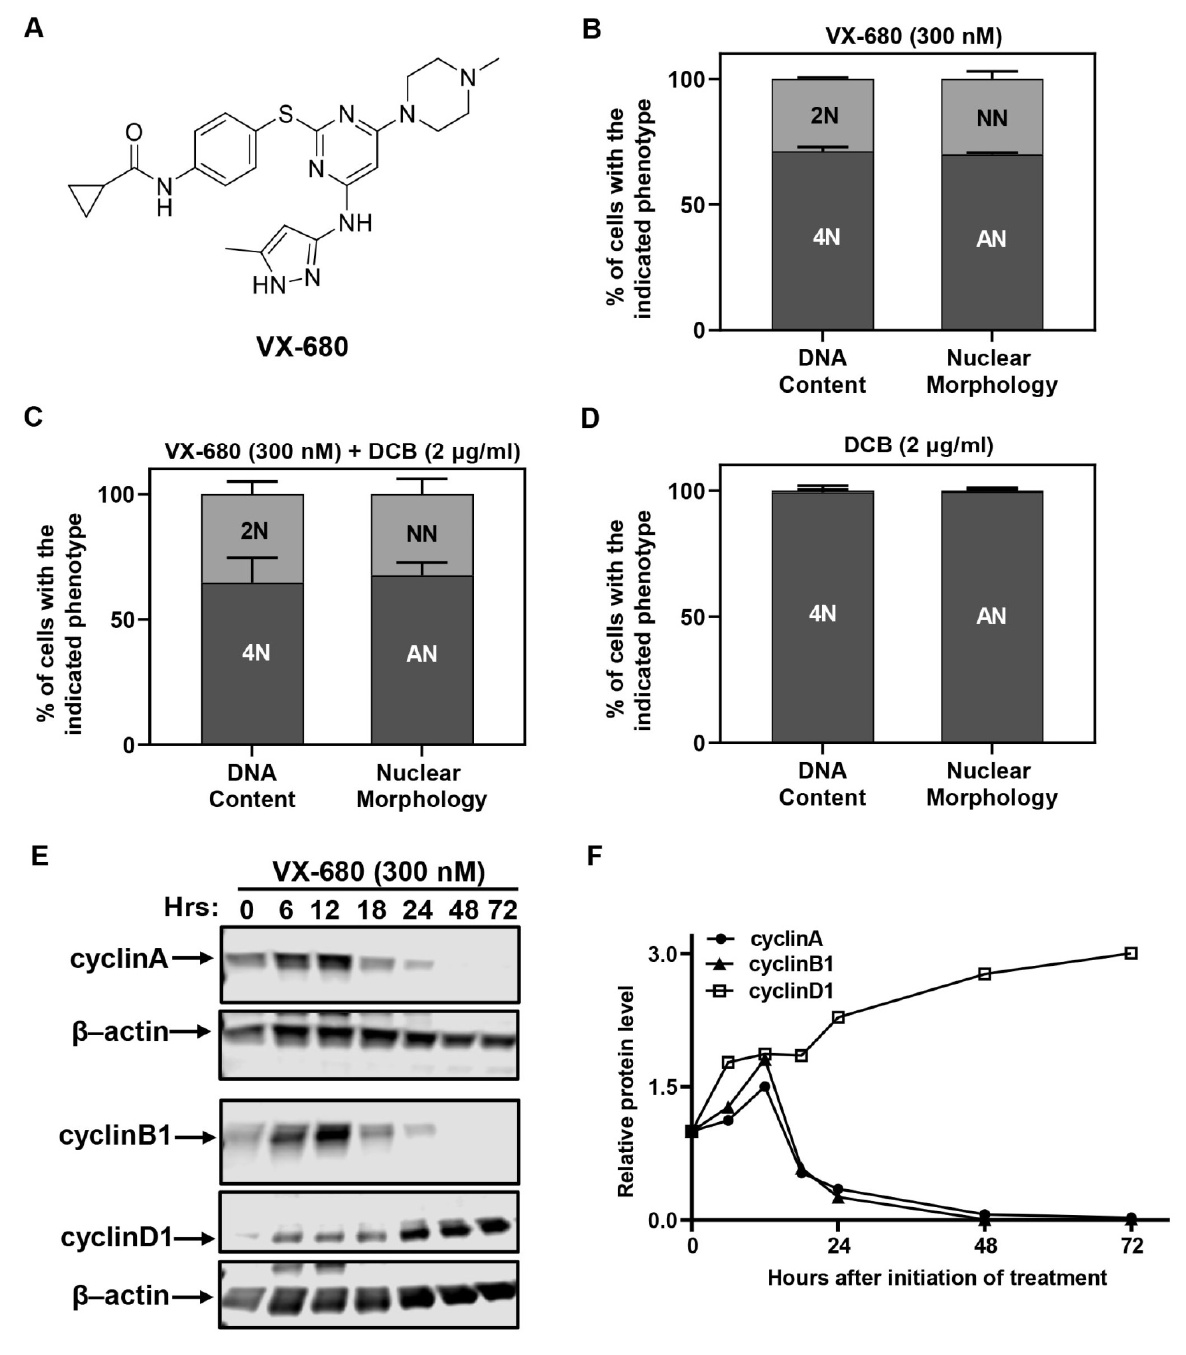
Figure 1. VX-680 arrests euploid cells in G1 with either 2N or 4N DNA content. ( A ) Chemical structure of VX-680. ( B – D ) RPE-NEO cells were treated with VX-680 ( B ), VX-680 + DCB ( C ) or DCB ( D ) for 3 days and then analyzed for DNA content by flow cytometry after propidium iodide (PI) staining or nuclear morphology after 4 ′ ,6-diamidino-2-phenylindole (DAPI) staining. ( E , F ) Western analysis ( E ) was used to quantify ( F ) the expression of cell cycle regulatory proteins with time of exposure. The blots were cropped, and the full-length original blots are presented in Supplementary Figure S4A,B. NN, cells with a normal nucleus; AN, cells with an abnormal nucleus. Data presented in ( B – D ) are expressed as the mean ± SD from three independent experiments, conducted in triplicate ( n = 9). The quantification of a representative experiment in ( E ) is presented in ( F ). Western blot was performed in two independent experiments.